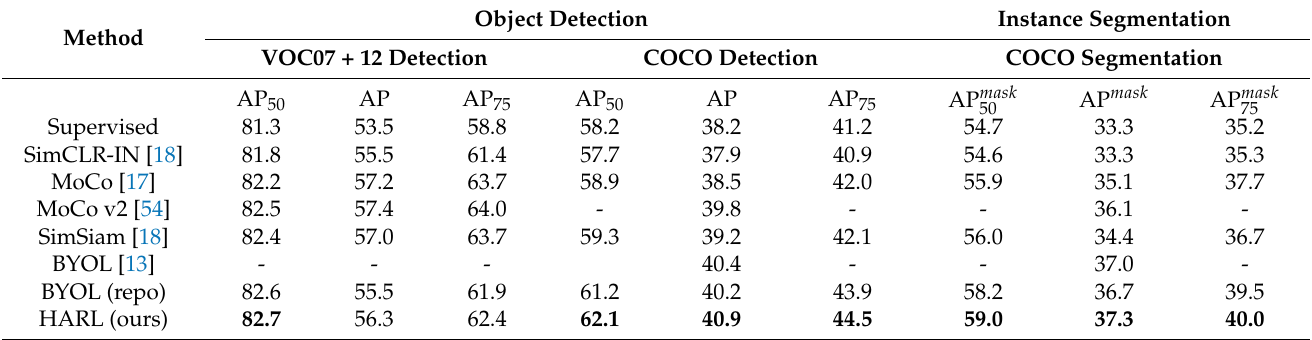
Table 3. Transfer learning to other downstream vision tasks. Benchmark the transfer learning performance between HARL framework and other self-supervised baselines on object detection and instance segmentation task. We use Faster R-CNN with C4 backbone for object detection and Mask- RCNN with FPN backbone for instance segmentation. Object detection and instance segmentation backbone initialize with the pre-trained ResNet-50 backbone on ImageNet 1000 classes. The best result is